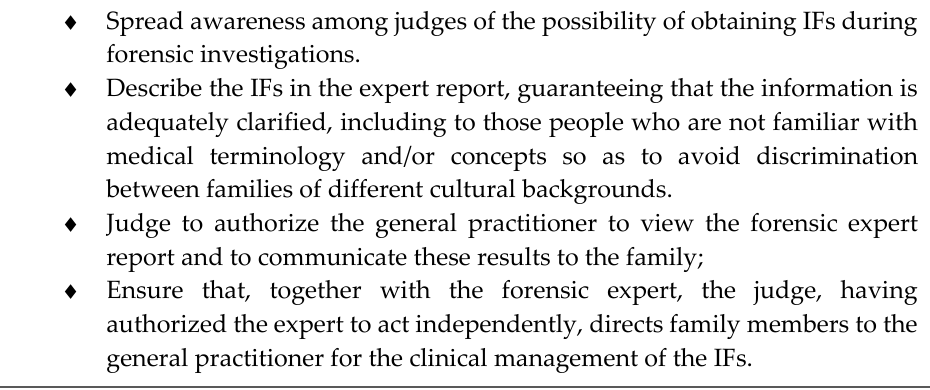
Figure 1. The box contains some indications of best practice for the management of incidental findings in forensics.